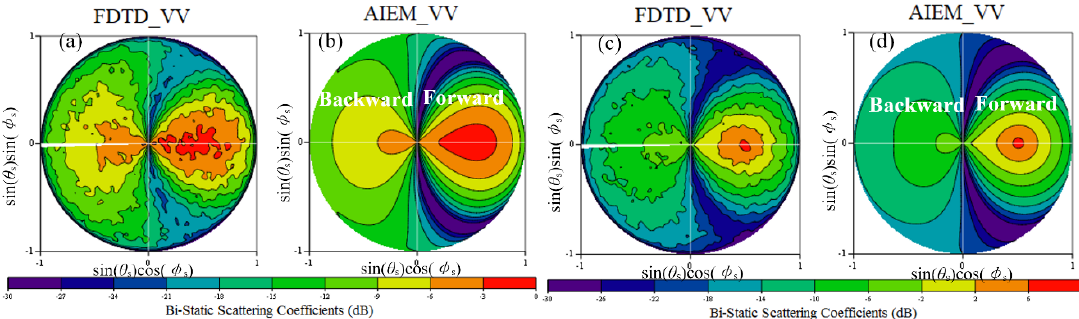
Figure 7. Comparisons between FDTD simulated upper ‐ space bi ‐ static scattering coefficients ( σ 0 ) and AIEM results, VV, 32 GHz, exponentially correlated rough surface, relative permittivity: 6.22 ‐ 2.86 j ; ( a ) and ( b ): correlation length l = 48 mm, RMS height h = 4 mm; ( c ) and ( d ): l = 24 mm, h = 2 mm.